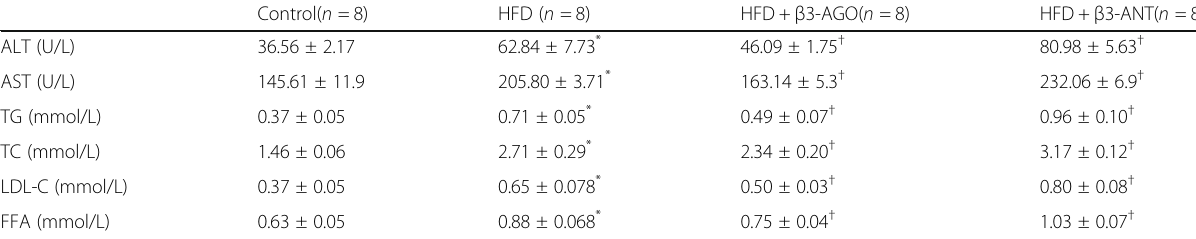
Table 2 Serum biochemical parameters of rats in the control, HFD, HFD + β 3-AGO and HFD + β 3-ANT groups